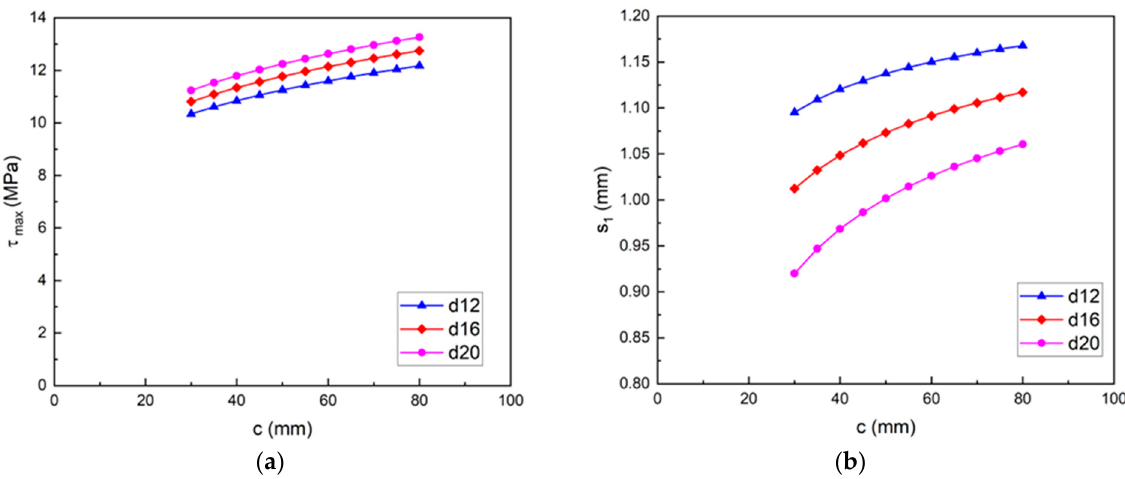
Figure 12. Influence of concrete cover on ( a ) bond strength and ( b ) corresponding slip.